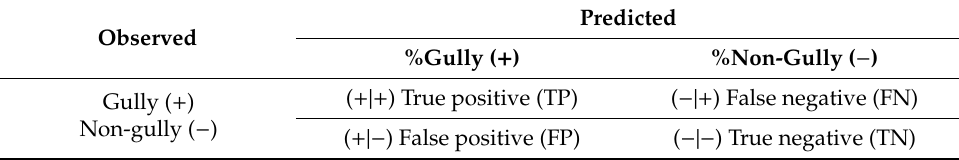
Table 2. Contingency matrix applied for the Multivariate Adaptive Regression Splines (MARS) model